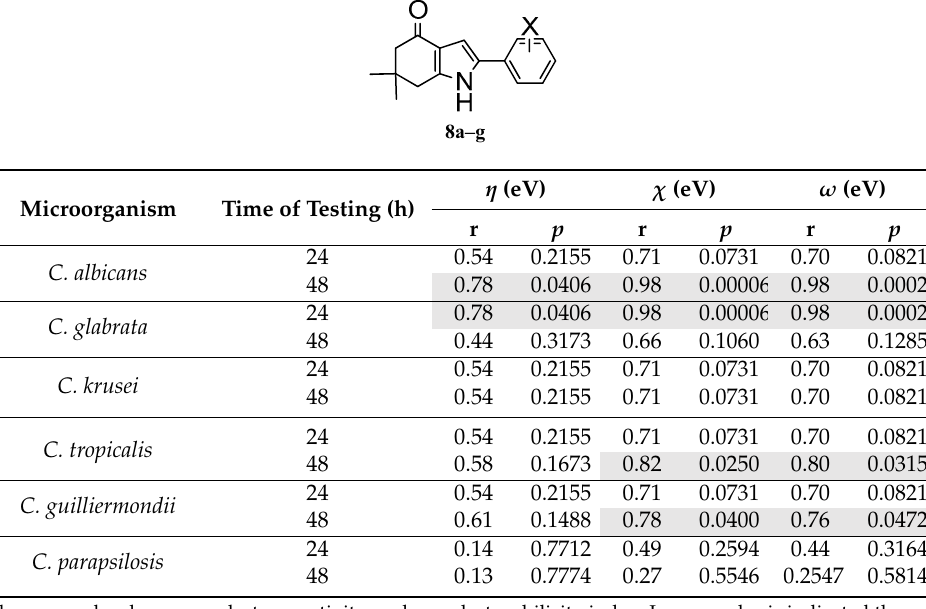
Table 5. Multiple regression analysis for series I: Compounds 6 and 7a – g .